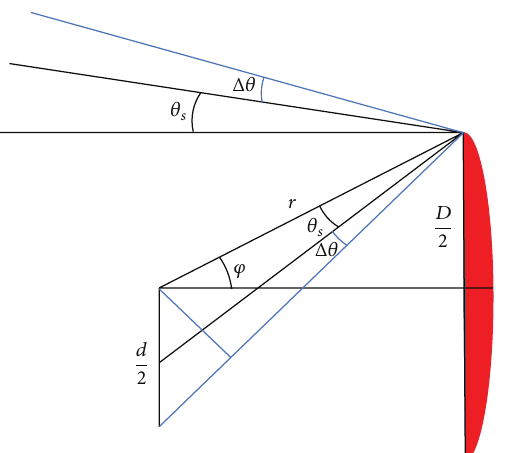
Figure 4: Concentrated sun flux by a parabolic dish mirror.